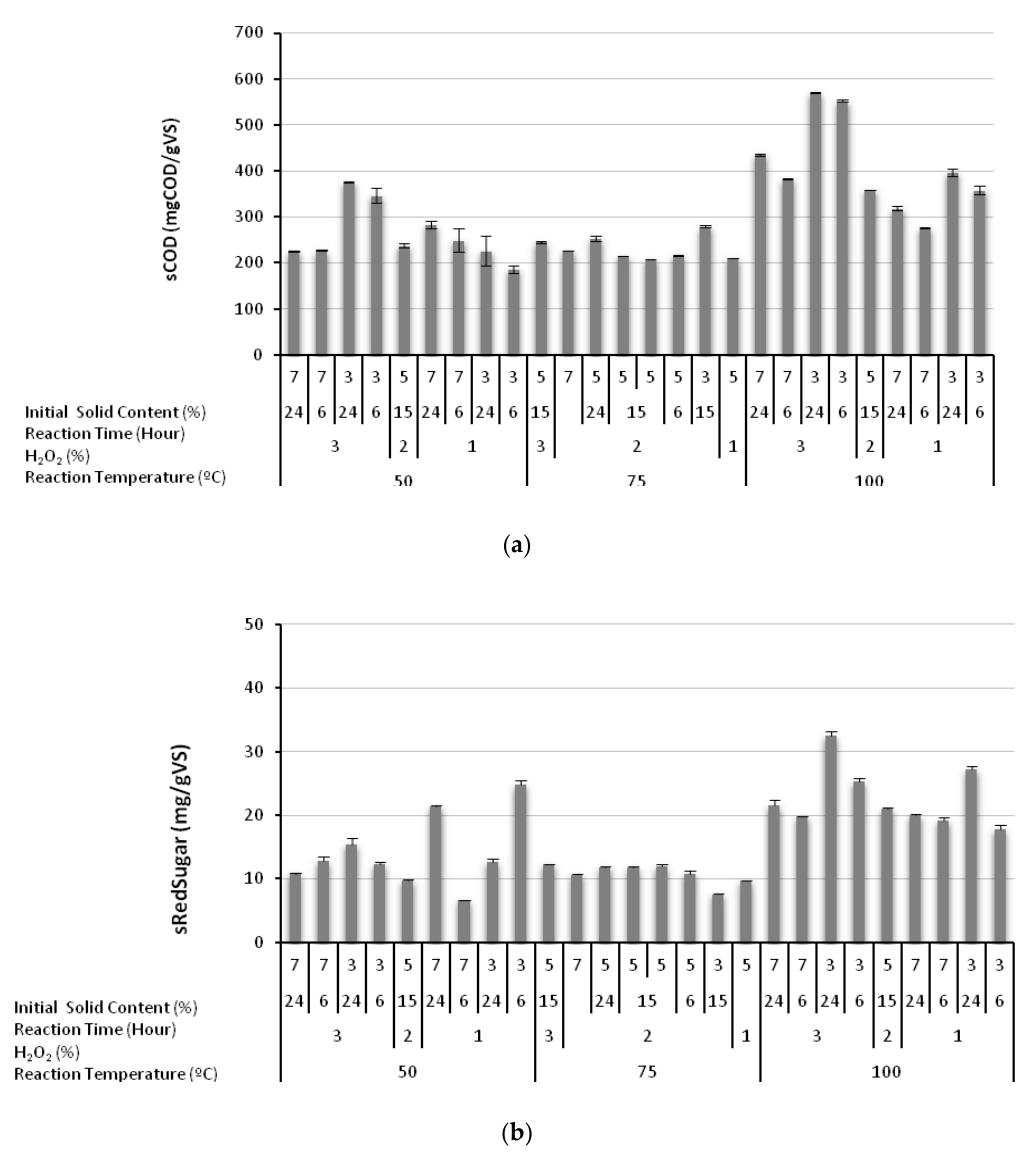
Figure 1. Increase in soluble chemical oxygen demand (sCOD; ( a )) and increase in soluble reducing sugar (sRedSugar; ( b) ) due to alkaline H 2 O 2 treatment.